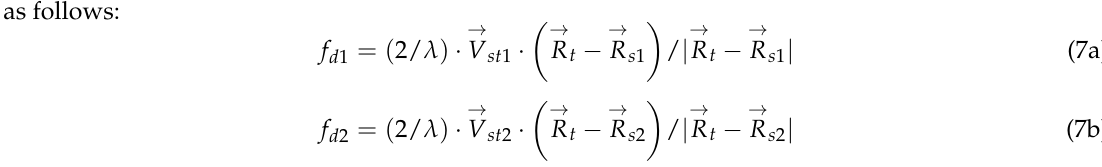
Figure 5. GEO SAR observation of target P c c P